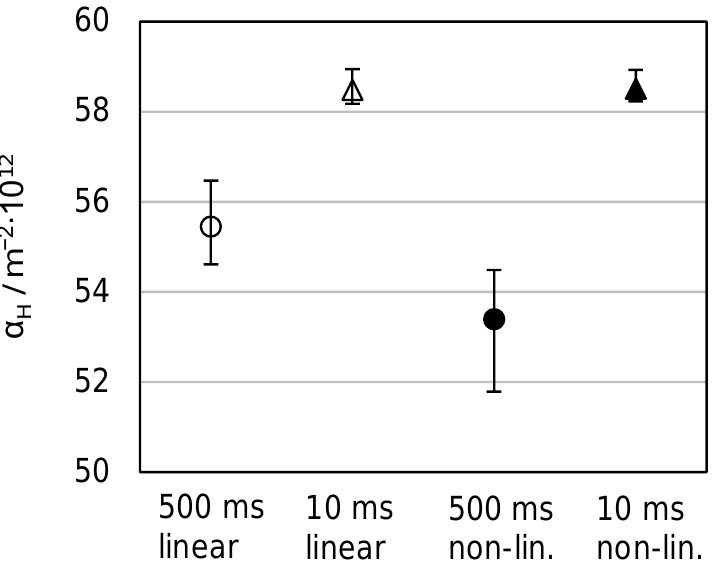
Figure 12. Effect on the filter cake resistance. Nonwoven measured with 25 m% PCC at 0.8 bar.